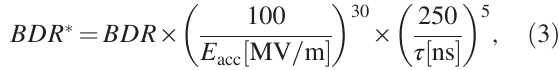
for pulse widths of 252 ns acc 30 acc